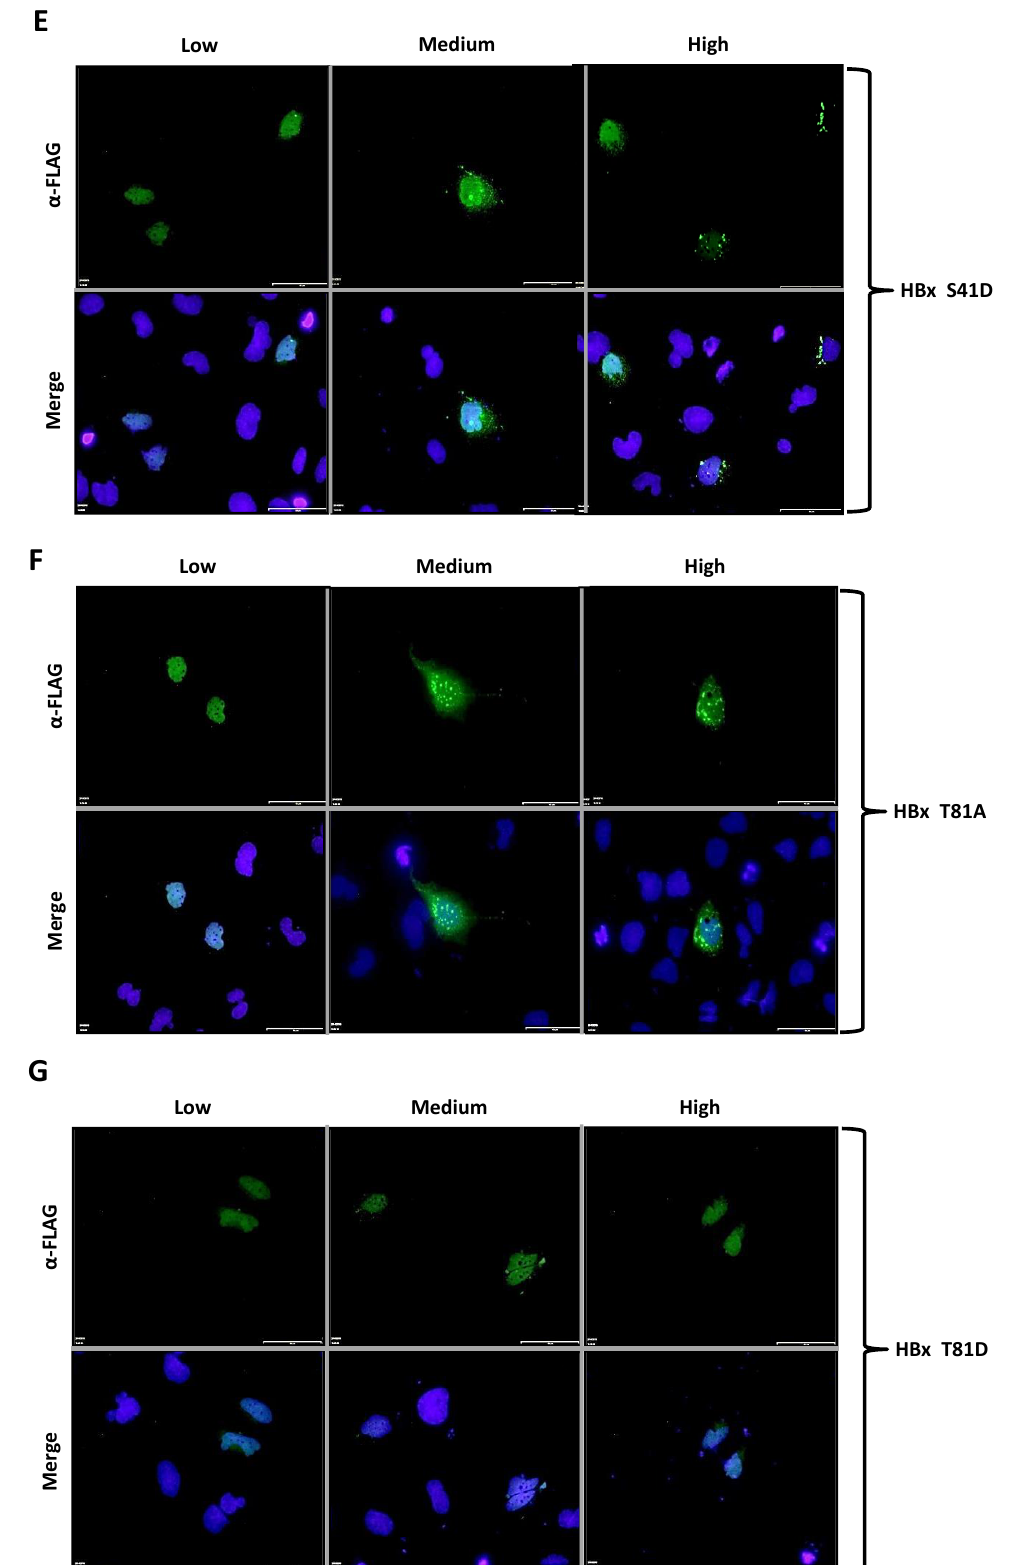
Figure 2. Immunofluorescence of the FLAG-tagged HBx protein and point mutant in cells. ( A ) Immunofluorescence of hepatoma cells transfected with low (left), medium (middle), and high (right) amounts of plasmid DNA containing WT 3xFLAG-HBx. Bottom panel shows nuclear DAPI signal merged with that of α-FLAG. ( B ) 3xFLAG HBx S25A, ( C ) 3xFLAG HBx S25D, ( D ) 3xFLAG HBx S41A, ( E ) 3xFLAG HBx S41D, ( F ) 3xFLAG HBx T81A, ( G ) 3xFLAG HBx T81D. Bar for scale of 50 µm.